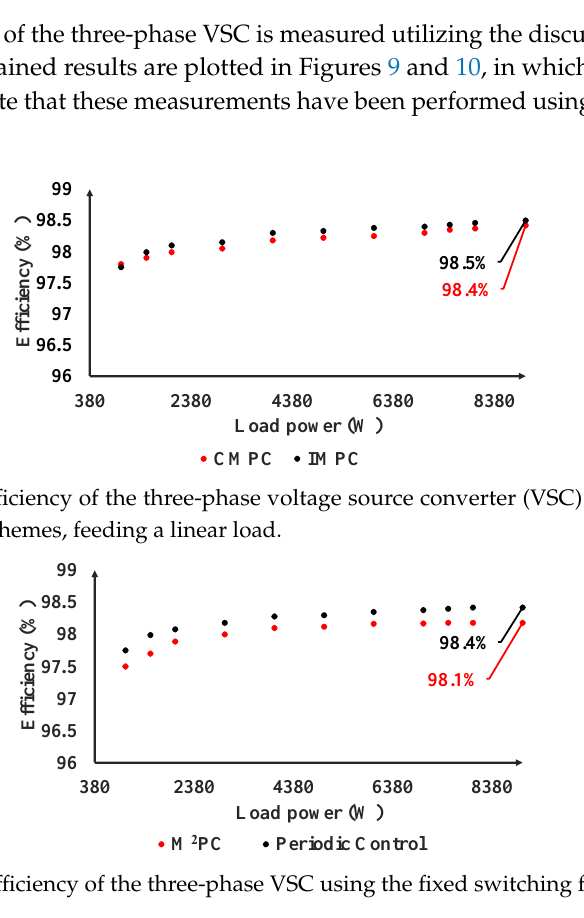
Figure 8. Obtained spectrum using different MPC schemes, where the average switching frequency of each MPC scheme is 5 kHz. ( a ) Conventional predictive scheme; ( b ) improved scheme; ( c ) periodic MPC scheme; and ( d ) MPC scheme with modulator.